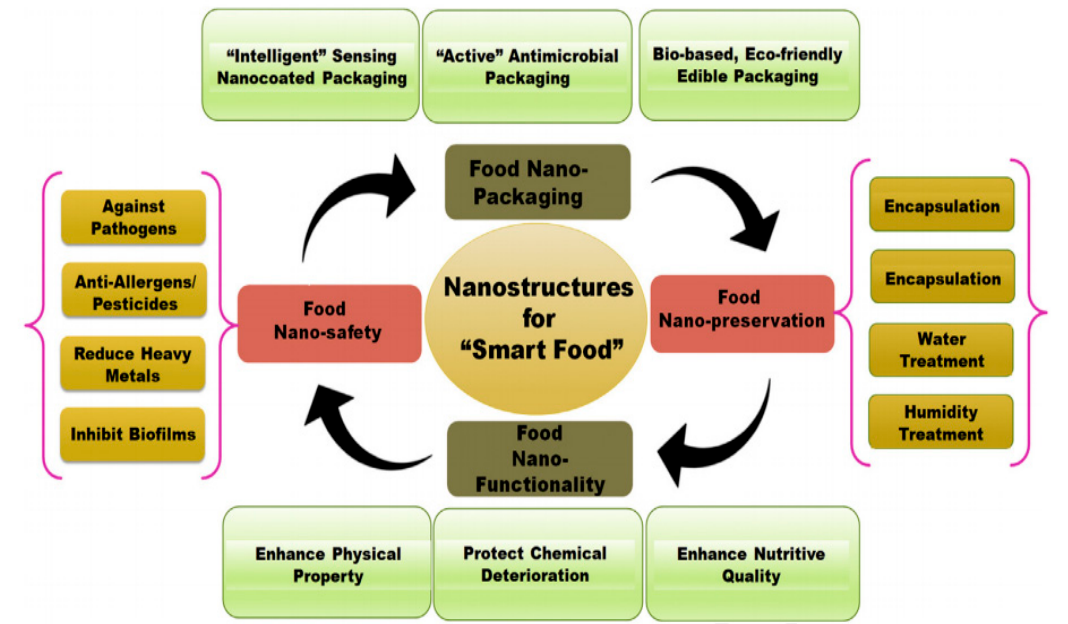
Figure 1. Systematic representation of application of nanoparticles in various areas of food industry. Reprinted with permission from [30]. Copyright 2018 Elsevier.